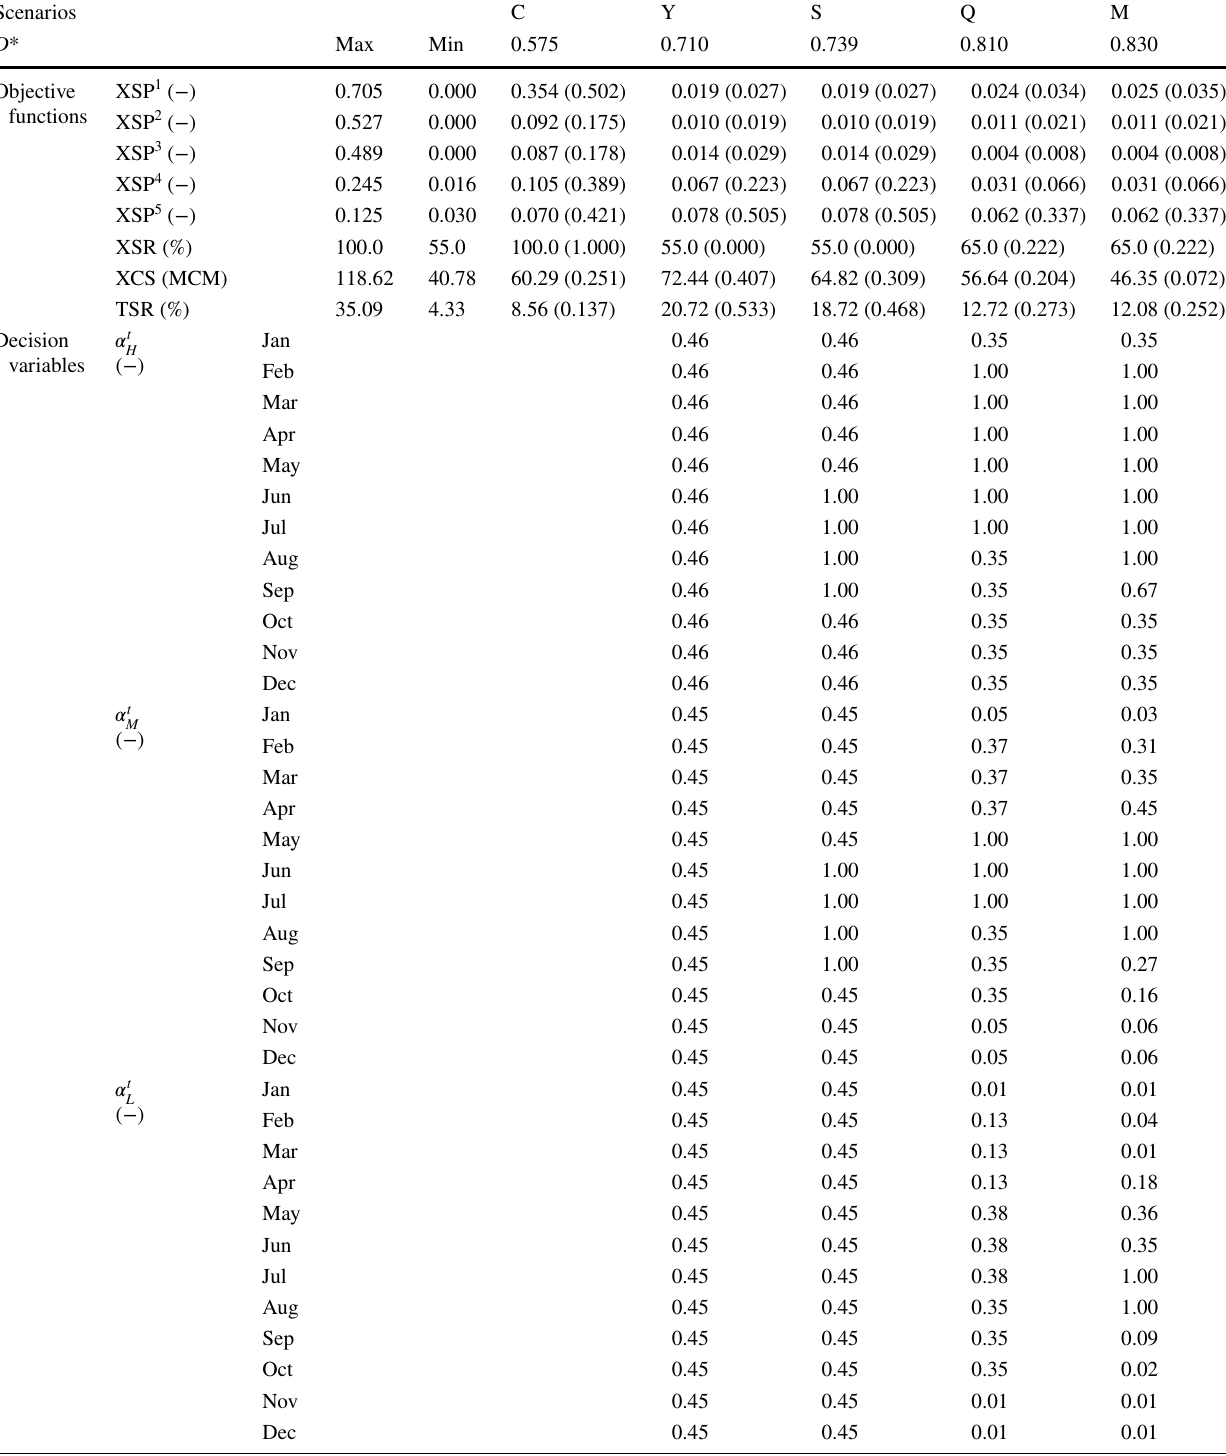
Table 2 Outcomes of current and optimization scenarios for the Nanhua Reservoir–Chiahsien Weir system